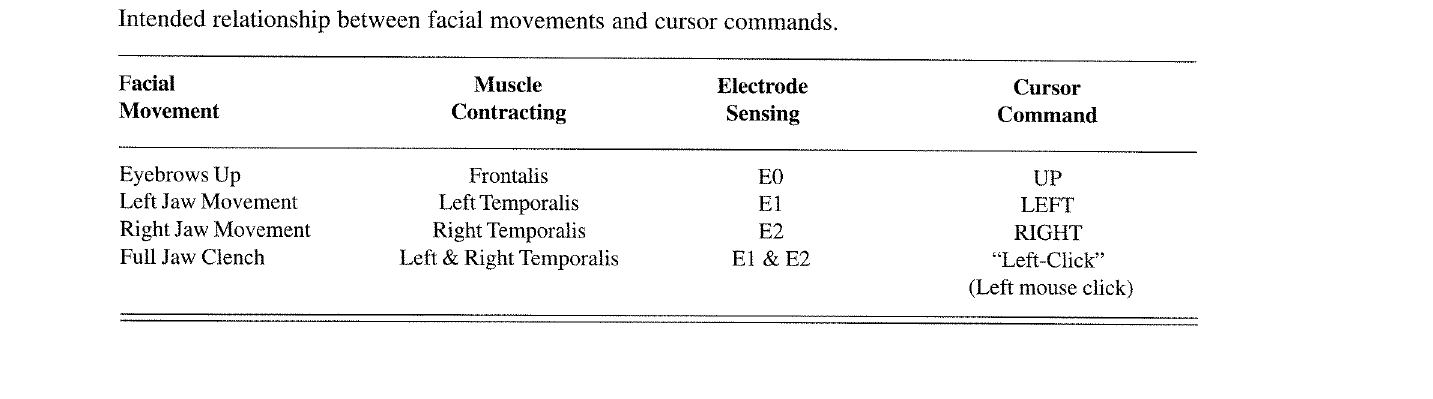
Intended relationship between facial movements and cursor commands. Facial